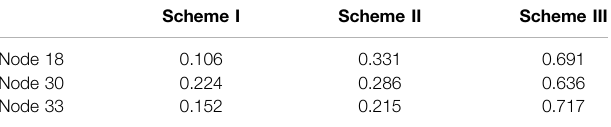
TABLE 4 | NVMs of speci fi c nodes on each